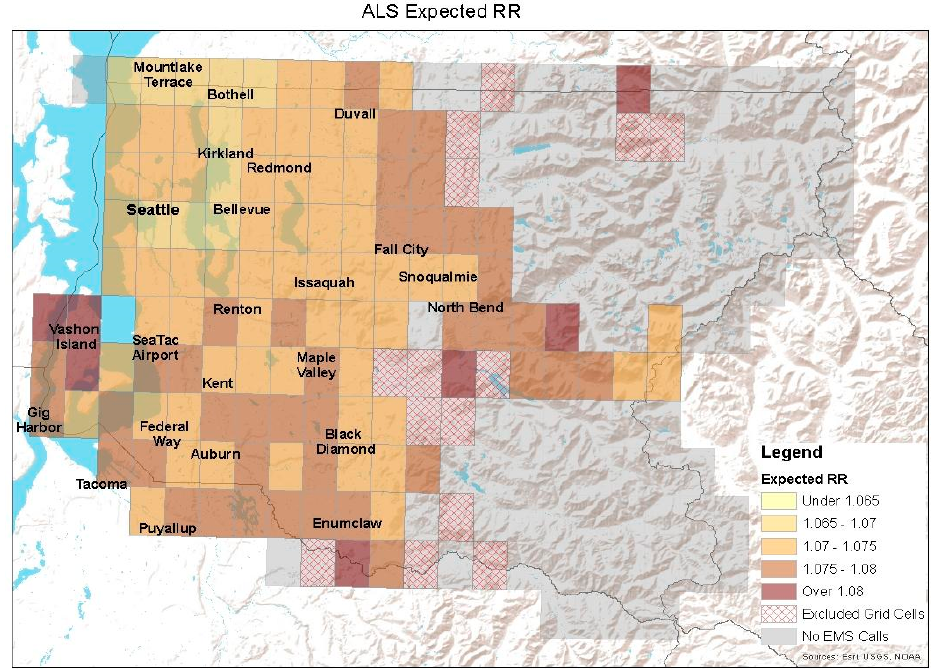
Figure A2. King County, Washington’s Grid map of expected RRs for ALS data with local city labels, where red checkers indicate grid cells without call data or too few call data to be included in the analysis. Each grid cell has size of 4 km by 7.5 km.